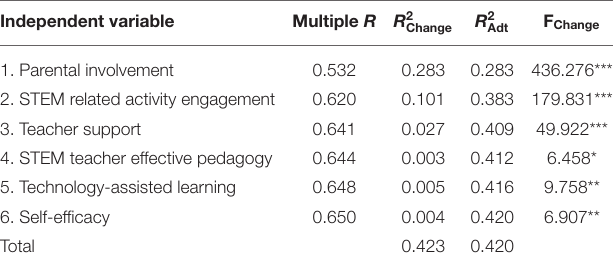
TABLE 1 | Multiple regression analysis of STEM college learning and career orientation as an outcome variable. Independent